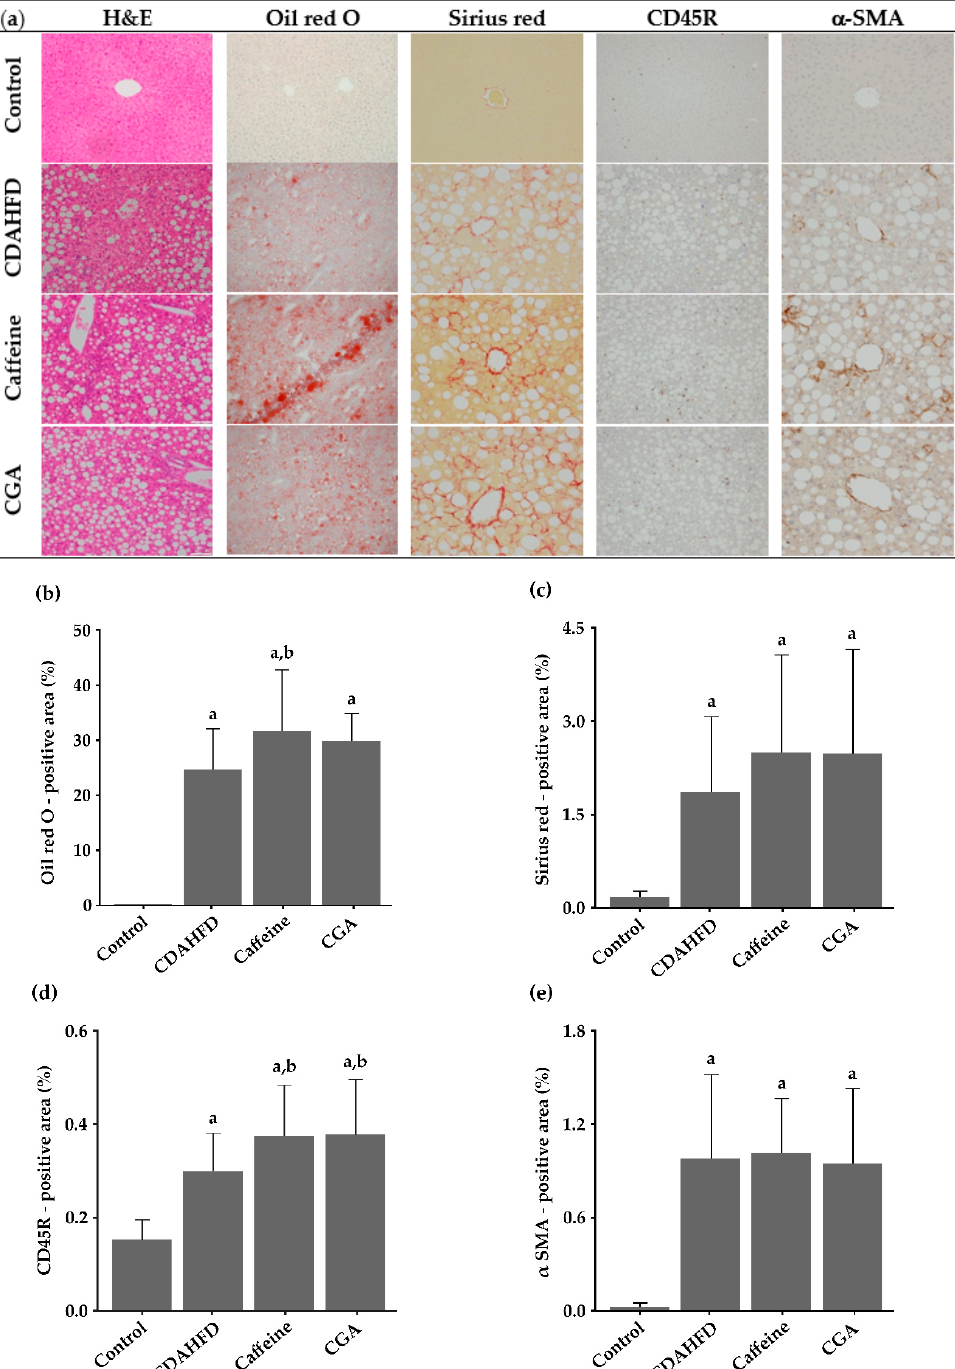
Figure 1. Photomicrographs of the liver ( a ) and results of quantitative image analysis ( b – e ). ( a ) The mice in the choline-deficient, L-amino acid-defined, high-fat diet (CDAHFD), ca ff eine, and chlorogenic acid (CGA) groups show liver histopathological features of nonalcoholic steatohepatitis (NASH).